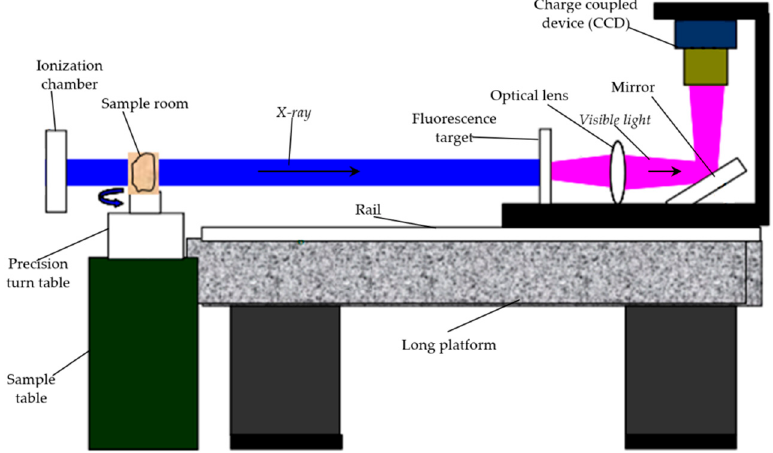
Figure 3. Scheme of the X-ray μ CT system at the Shanghai Institute of Applied Physics.